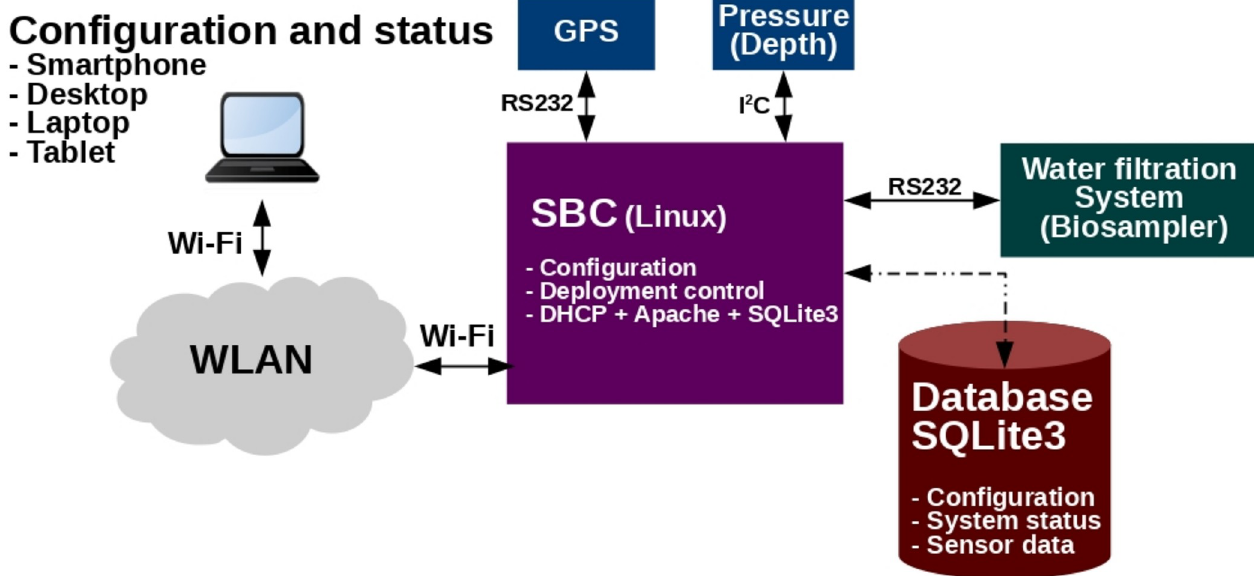
Fig 6. High level control and configuration. The user interface is based on a web page where the mission is configured and then saved on a local database (SSD disk). The mission in then passed to the embedded electronics through a RS-232 protocol.